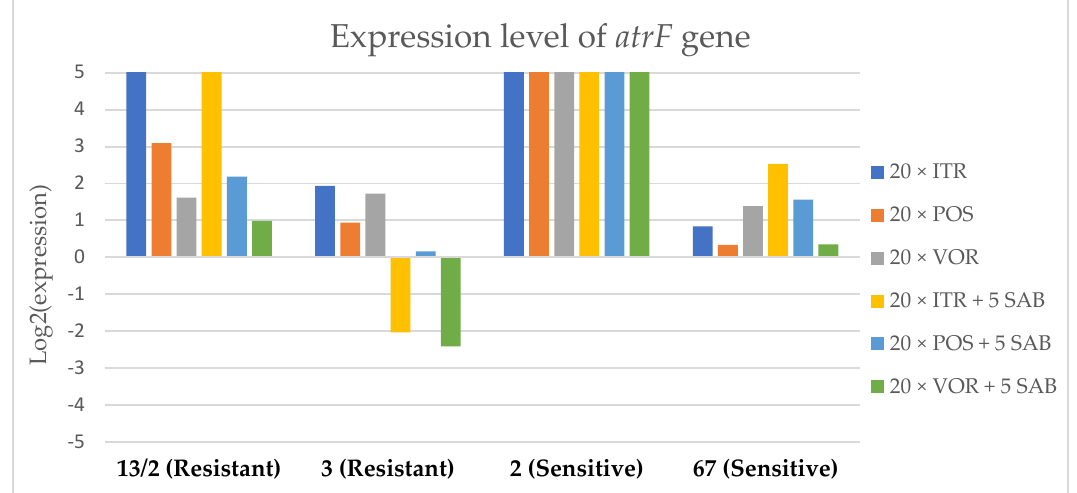
followed by 5 times culturing on only SAB. Microorganisms 2020 , 8 , x FOR PEER REVIEW